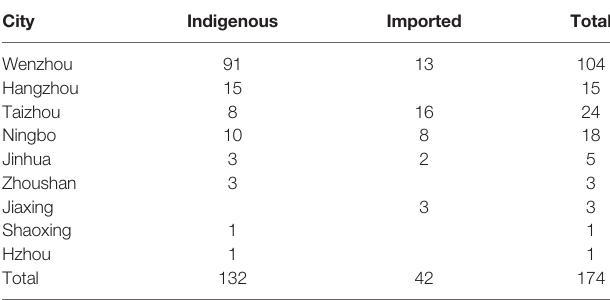
TABLE 1 | Demographic characteristics of dengue cases in Zhejiang Province, 2019.